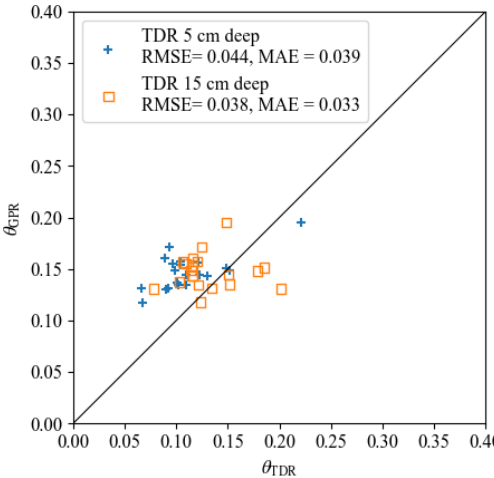
Figure 10. Comparison between soil moisture results of GPR (sensitivity down to about 40 cm) and TDR (5 and 15 cm